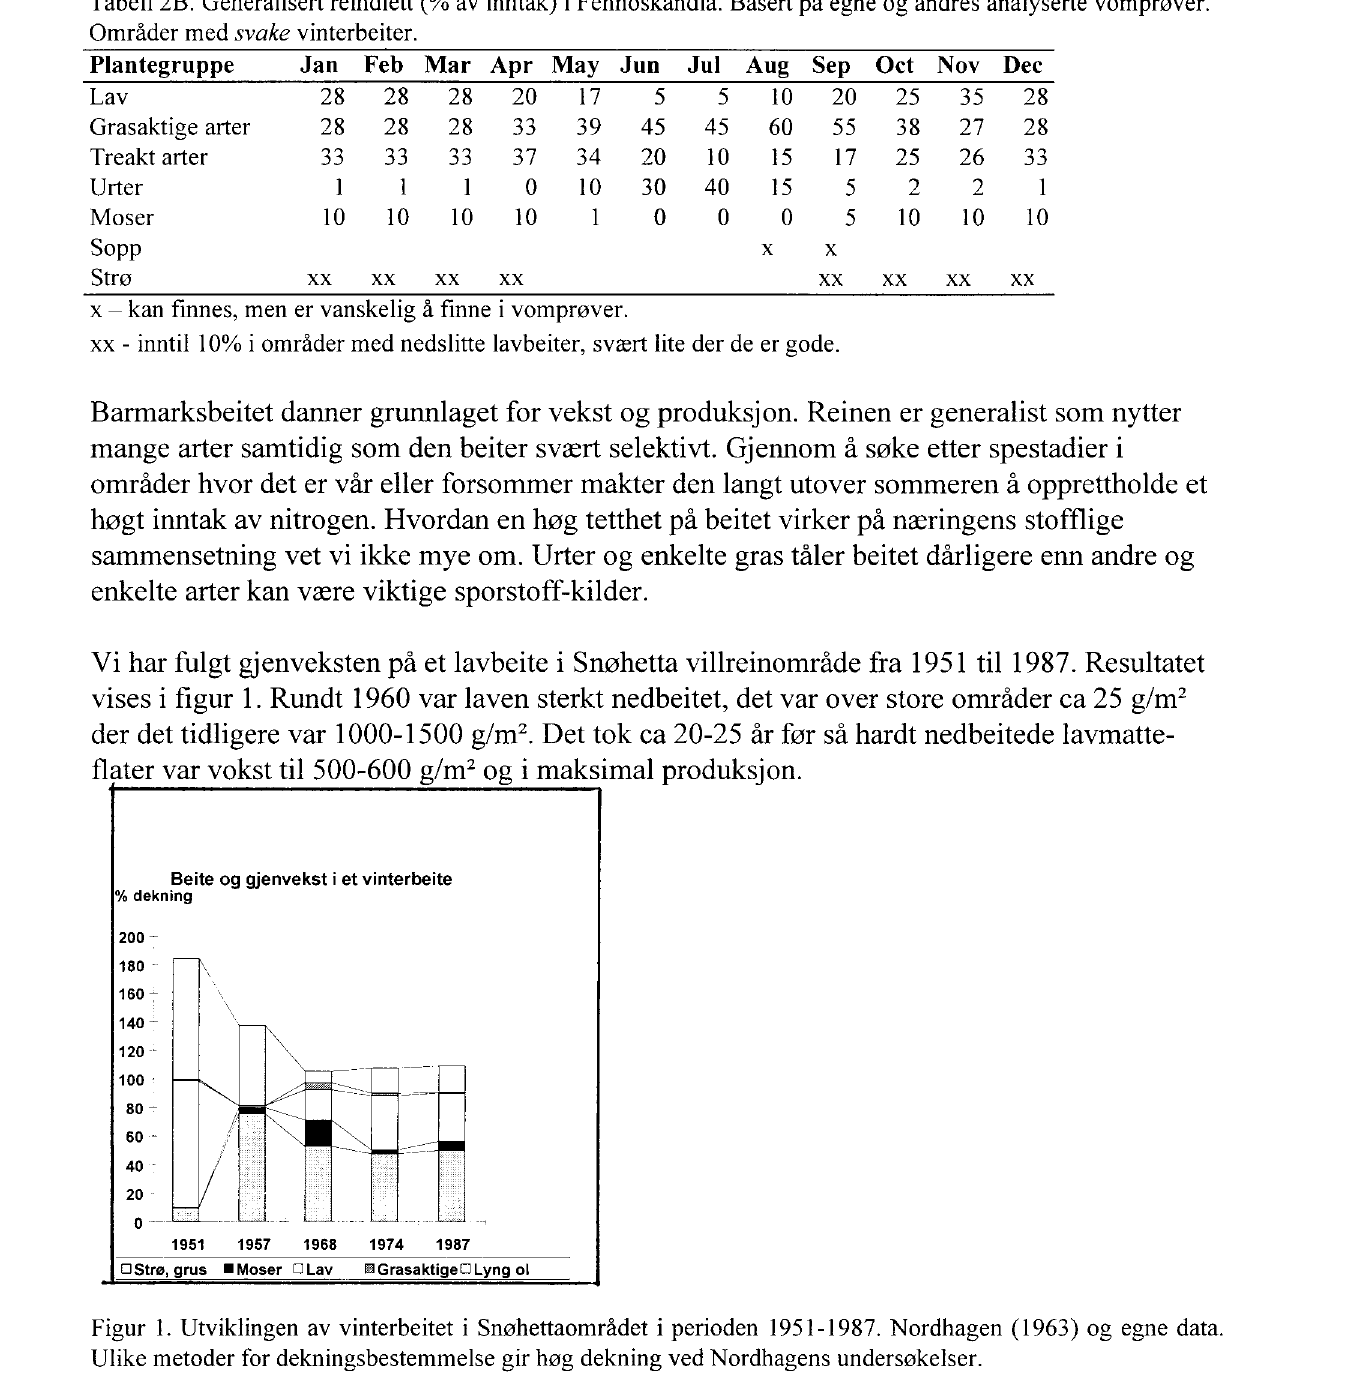
Figur 1. Utviklingen av vinterbeitet i Snøhettaområdet i perioden 1951-1987. Nordhagen (1963) og egne data. Ulike metoder for dekningsbestemmelse gir høg dekning ved Nordhagens undersøkelser.